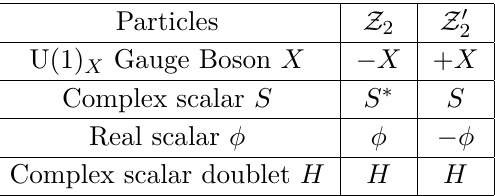
Table 1 . Fields beyond the SM together with SM Higgs doublet ( H ) and their charges under the symmetry Z 2 × Z 0 2